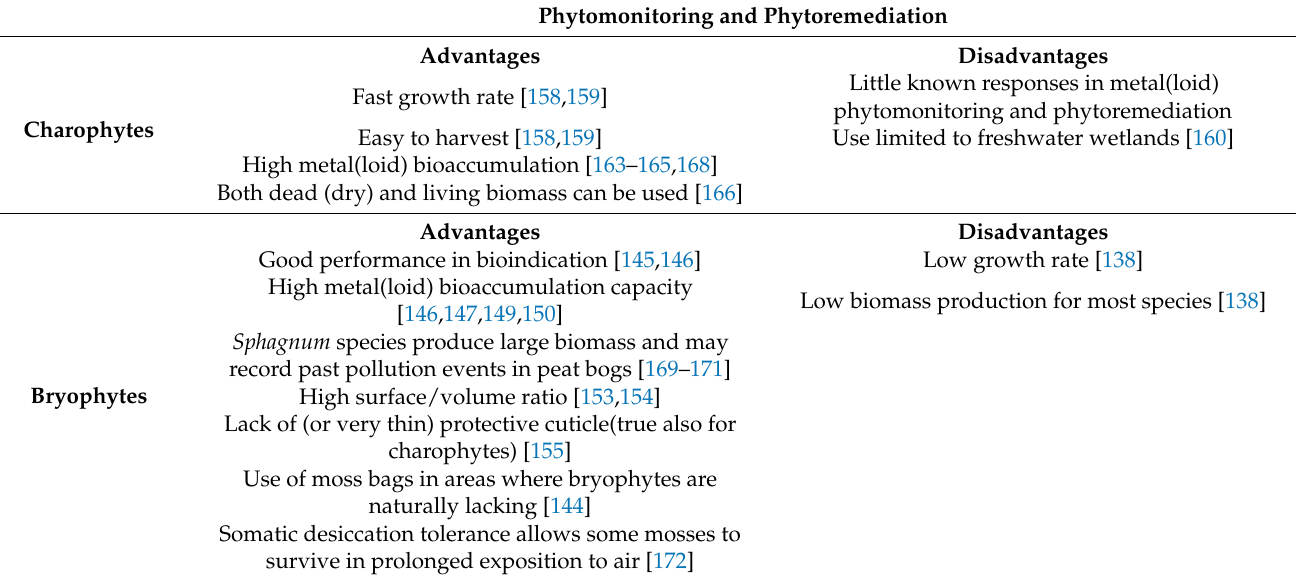
Table 3. Advantages and disadvantages of the utilization of charophytes and bryophytes in metal(loid) phytomonitoring and